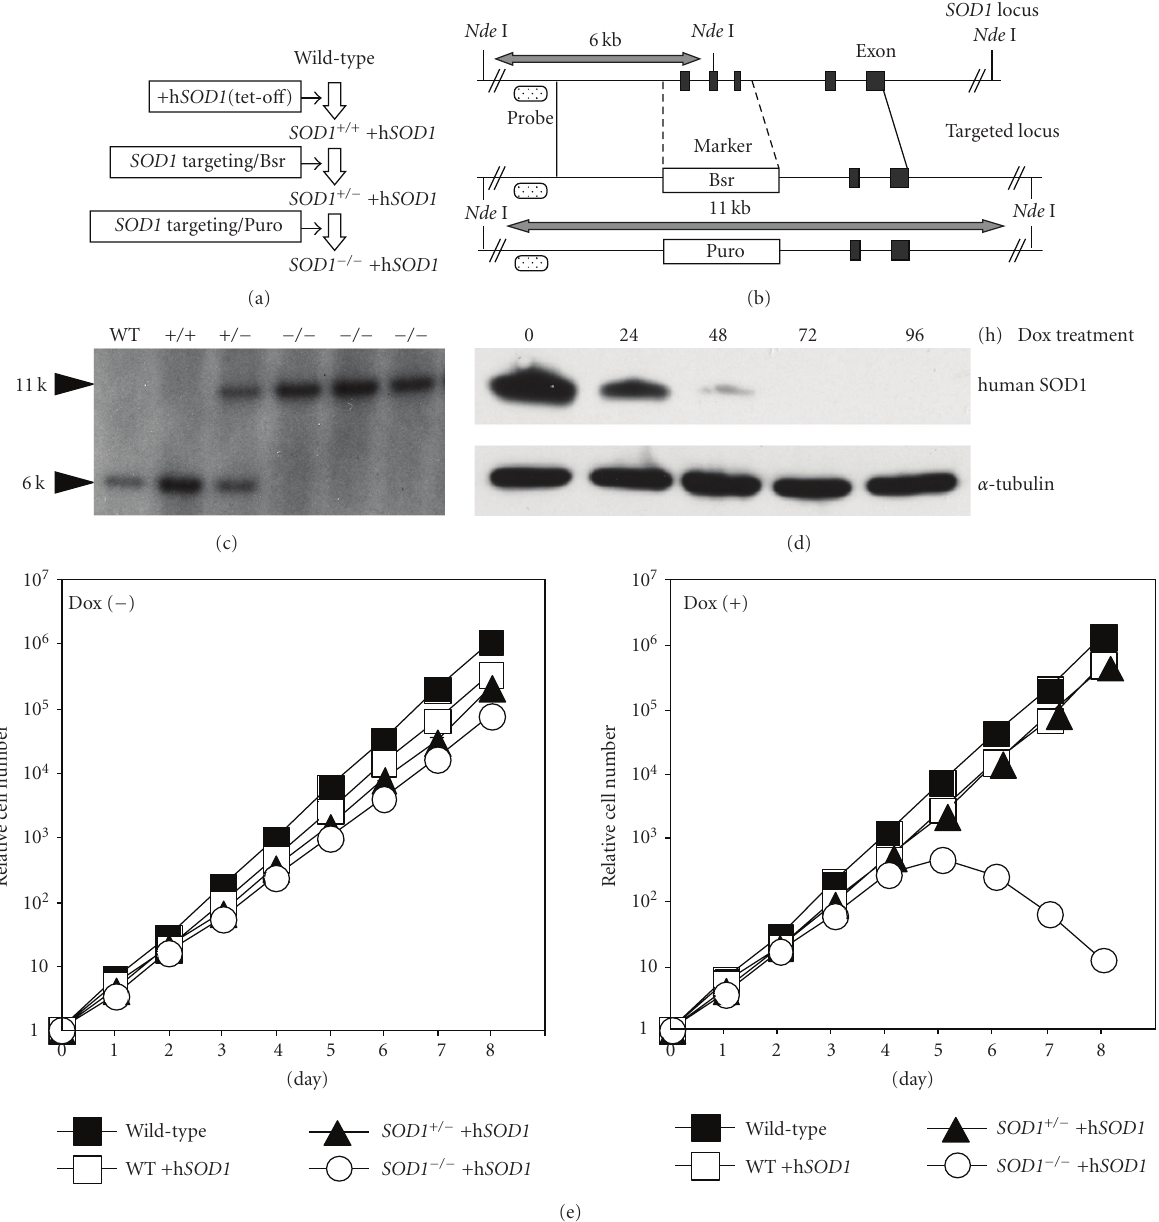
Figure 1: Generation of SOD 1 − / − cells expressing human SOD1 from the tet-o ff promoter. (a) Schematic representation of the generation of DT40 SOD 1 − / − + h SOD1 cells. (b) Schematic representation of the SOD1 genomic locus and configuration of the targeted locus. (c) Southern blot analysis for the confirmation of the status of the SOD1 wild-type (WT), WT + human SOD1 (+/+), heterozygous (+/ − ), and homozygous ( − / − ) cells, using Nde I digested genomic DNA and the probe indicated in (b). (d) Dox-dependent disappearance of human SOD1, as confirmed by western blot analysis, with α -tubulin used as the loading control. (e) Growth curves of indicated genotype cells. Indicated mutant cells were cultured in the presence or absence of 1 μ g/mL Dox. Dox had no e ff ect on the growth or viability of wild-type